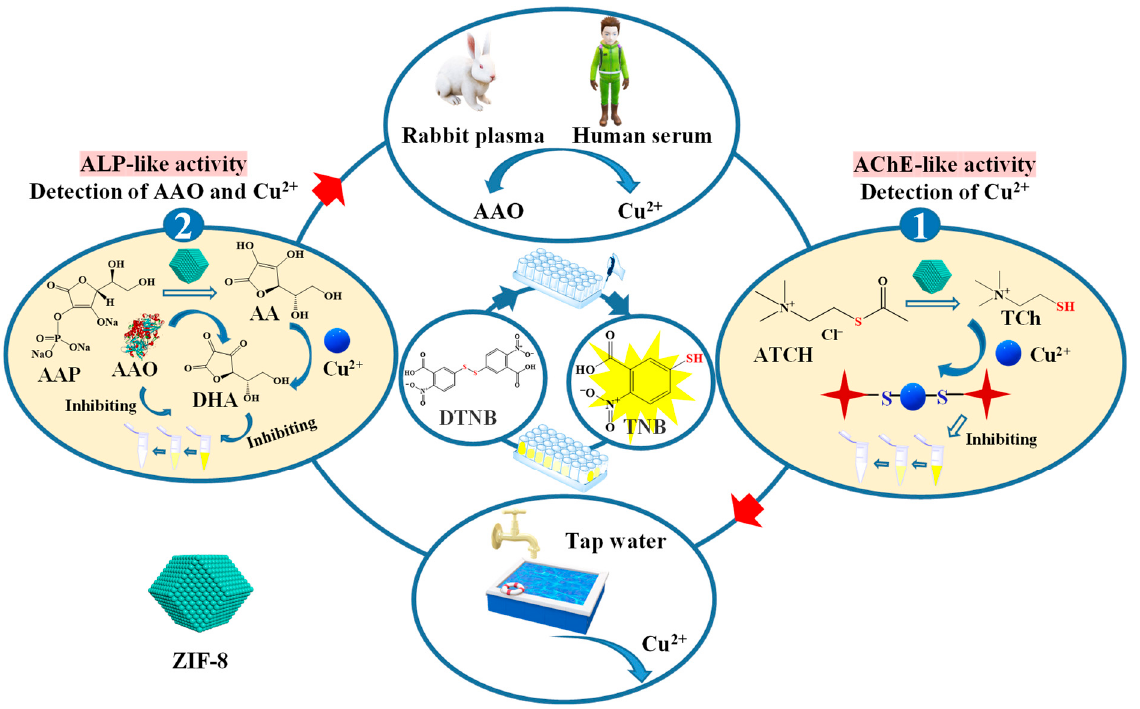
Figure 1. Schematic illustration for the detection of AAO and Cu 2+ based on the AChE- and ALP-like activities of